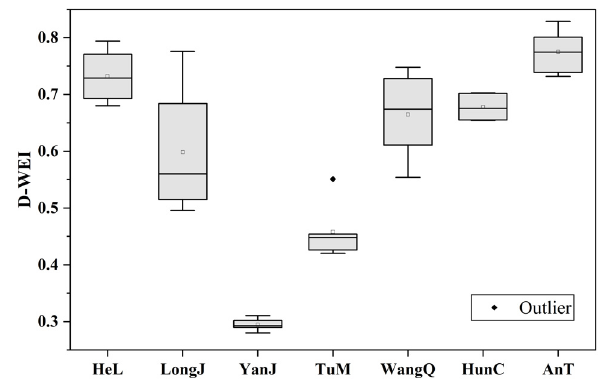
Figure 5. Comparison of domestic water use efficiency in the TRB’s regions.